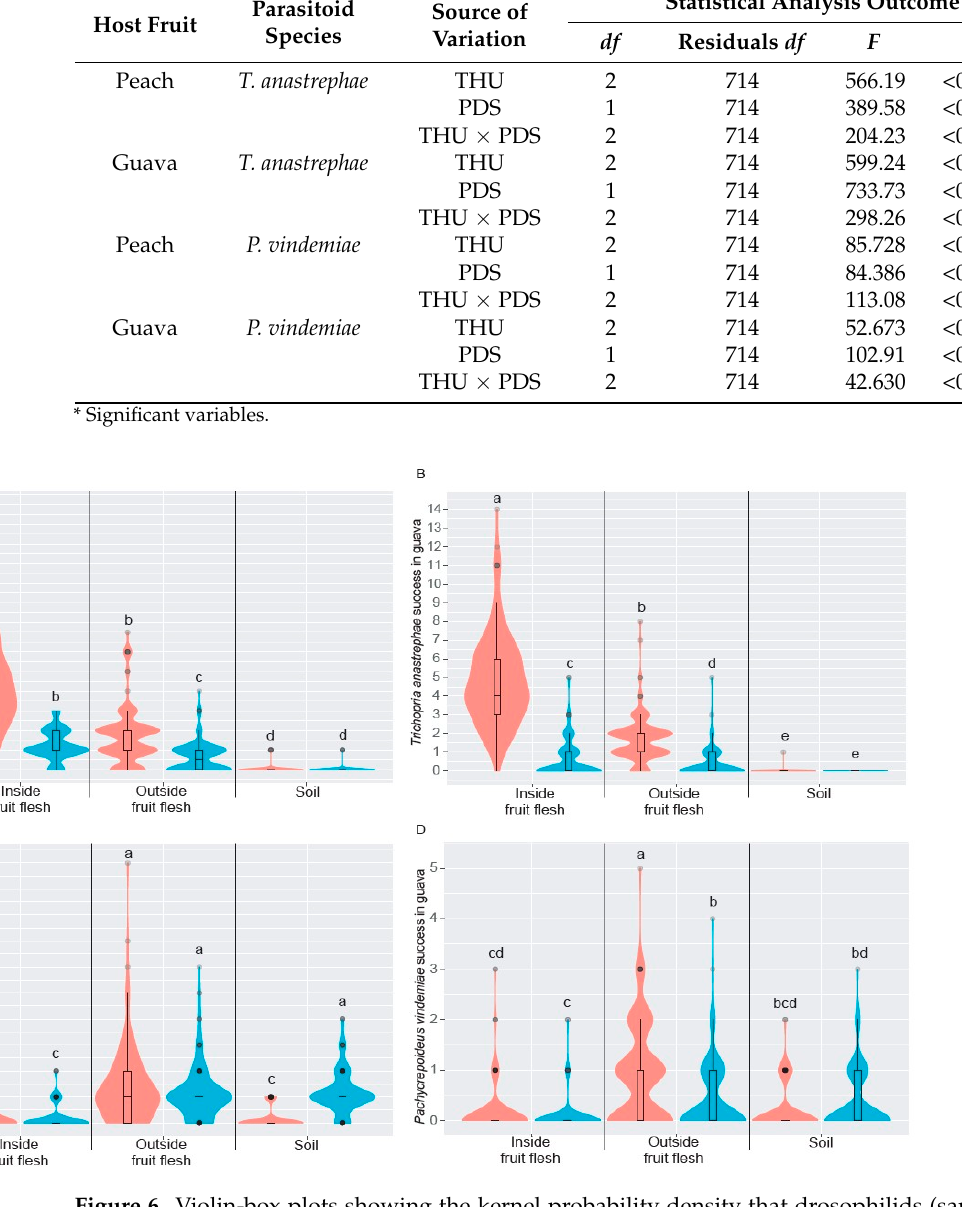
Figure 6. Violin-box plots showing the kernel probability density that drosophilids (saprophytic Drosophila spp. from D. melanogaster group = red, and Drosophila suzukii = blue) are parasitized in a different microhabitat by ( A ) Trichopria anastrephae in peach, ( B ) Trichopria anastrephae in guava, ( C ) Pachycrepoideus vindemiae in peach, and ( D ) Pachycrepoideus vindemiae in guava. Different letters show significant differences at p = 0.05 (LSD test with the Bonferroni–Holm adjustment method). The rectangular white bar in the center of the violin box and the black horizontal line inside the bar show the interquartile range and the median, respectively; the black vertical lines stretched from the bar show the lower/upper adjacent values, while black dots display the outlier data.